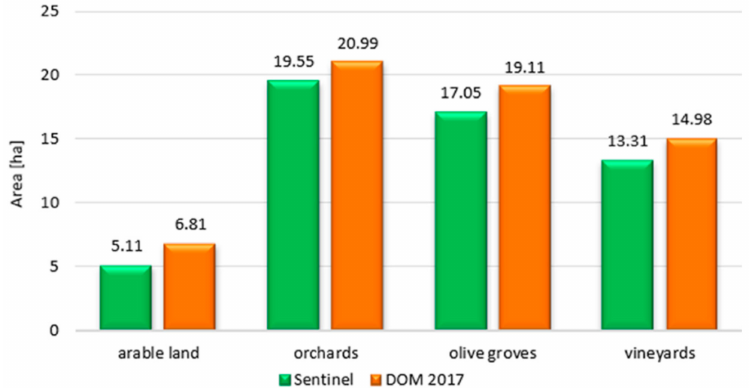
Figure 6. Burned area by land use. Results obtained using the Sentinel satellite images and digital orthophoto